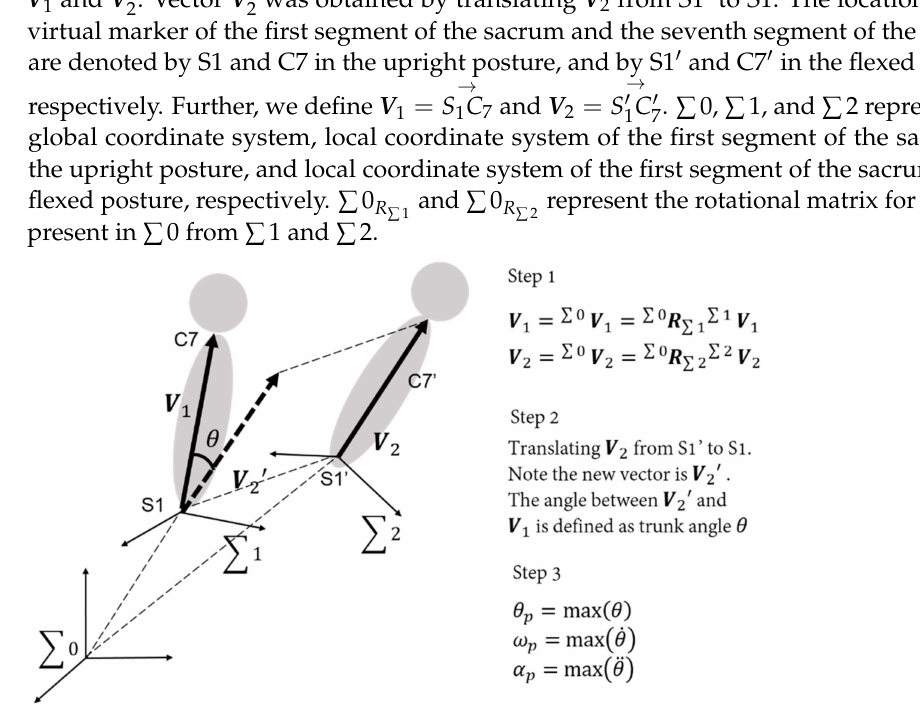
Figure 3. Trunk flexion angle θ represents the angle between the trunk vector at the stand-still posture and flexed posture, which starts from the first sacrum segment to the seventh cervical segment. The peak trunk angle, peak trunk angular velocity ( ω p ), and peak trunk angular acceleration ( α p ) are determined from Steps 1 to